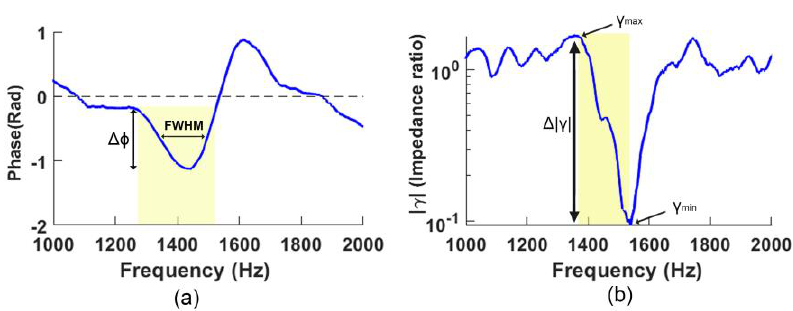
Figure 8. Example of quantifying a resonance based on the R2 from measurement C7 in Figure 7: ( a ) ( a ) PQV = ∆ φ /FWHM; ( b ) GMMR = γ Local Maximum/ γ Local Minimum PQV = Δ ϕ /FWHM; ( b ) GMMR = γ Local Maximum/ γ Local Minimum .